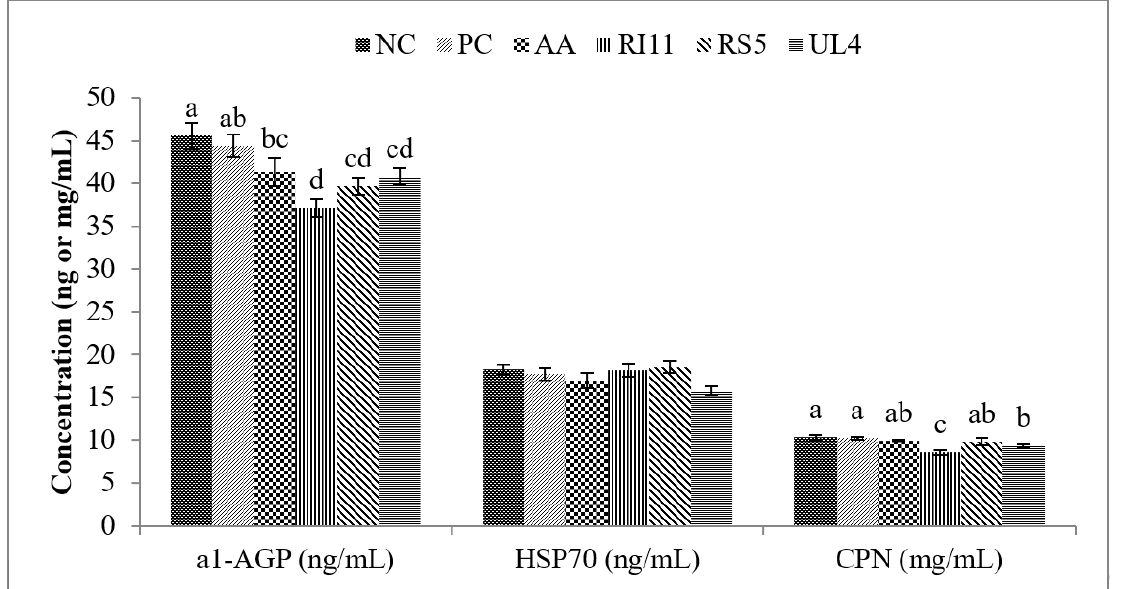
Figure 1. E ff ect of feeding di ff erent postbiotics on plasma acute phase proteins ( α 1-AGP and CPN), and HSP70 concentrations in heat-stressed broiler chickens. a,b,c,d standard error bars sharing di ff erent letters are significantly di ff erent ( p < 0.05). Data are shown as means and standard error ( n = 12). α 1-AGP: alpha-1-acid-glycoprotein, HSP70: heat shock protein 70, CPN: ceruloplasmin. Diets: Negative control (NC): basal diet without any supplementation, positive control (PC): basal diet + 0.02% oxytetracycline ( w / w ), AA: basal diet + 0.02% ascorbic acid ( w / w ), RI11: basal diet + 0.3% postbiotic RI11 ( v / w ), RS5: basal diet + 0.3% postbiotic RS5 ( v / w ), UL4: basal diet + 0.3% postbiotic UL4 ( v / w